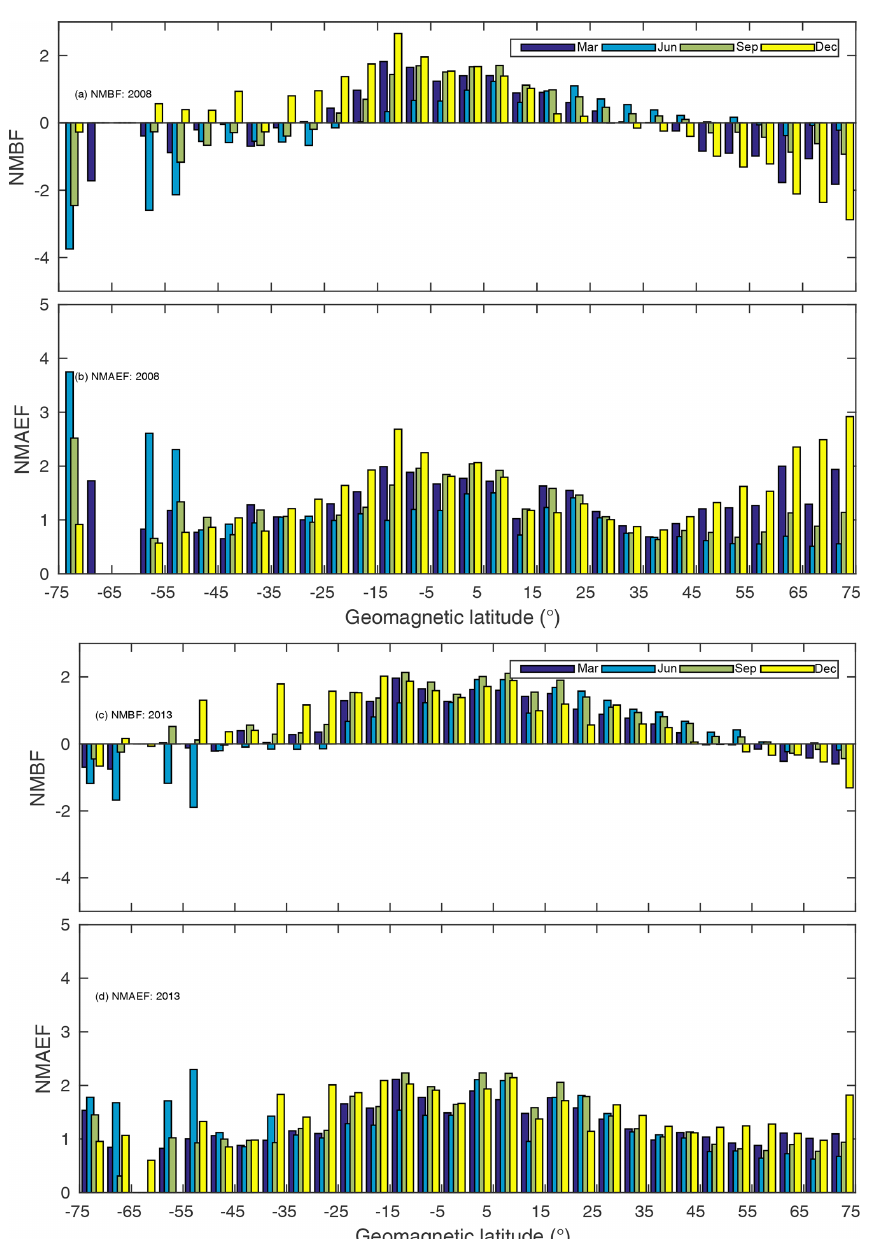
Figure 3. The same as Fig. 2 but for NMBF and